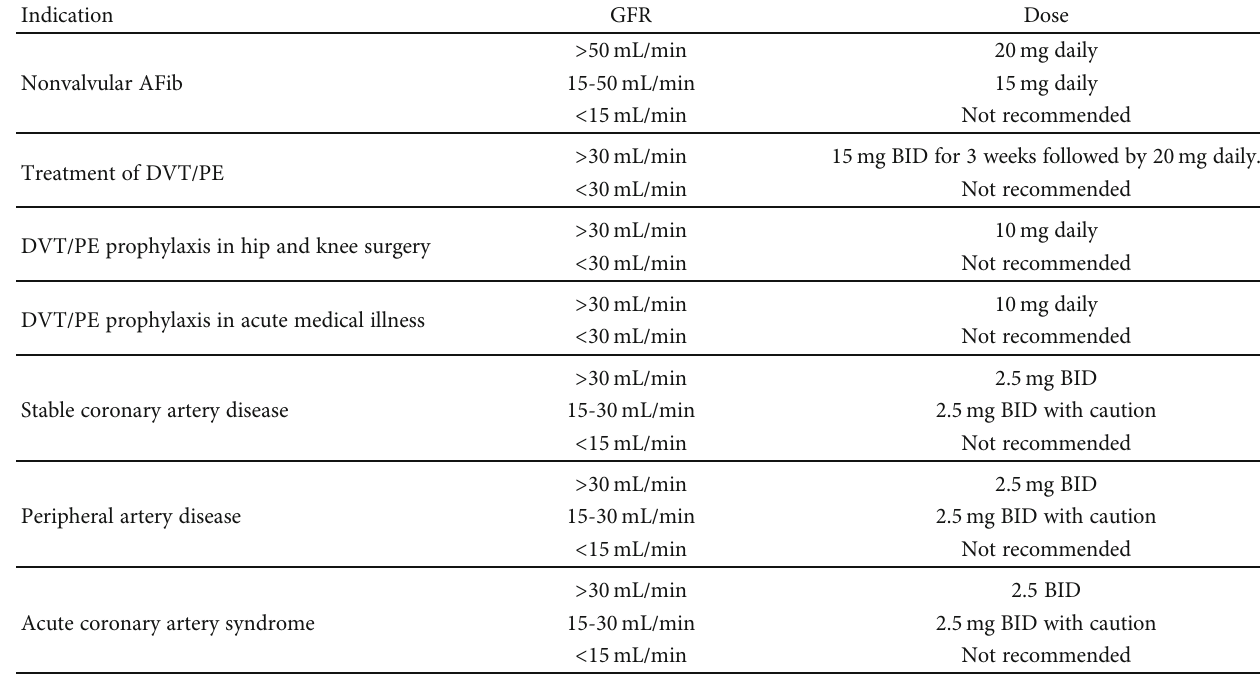
Table 2: Rivaroxaban dosage in various